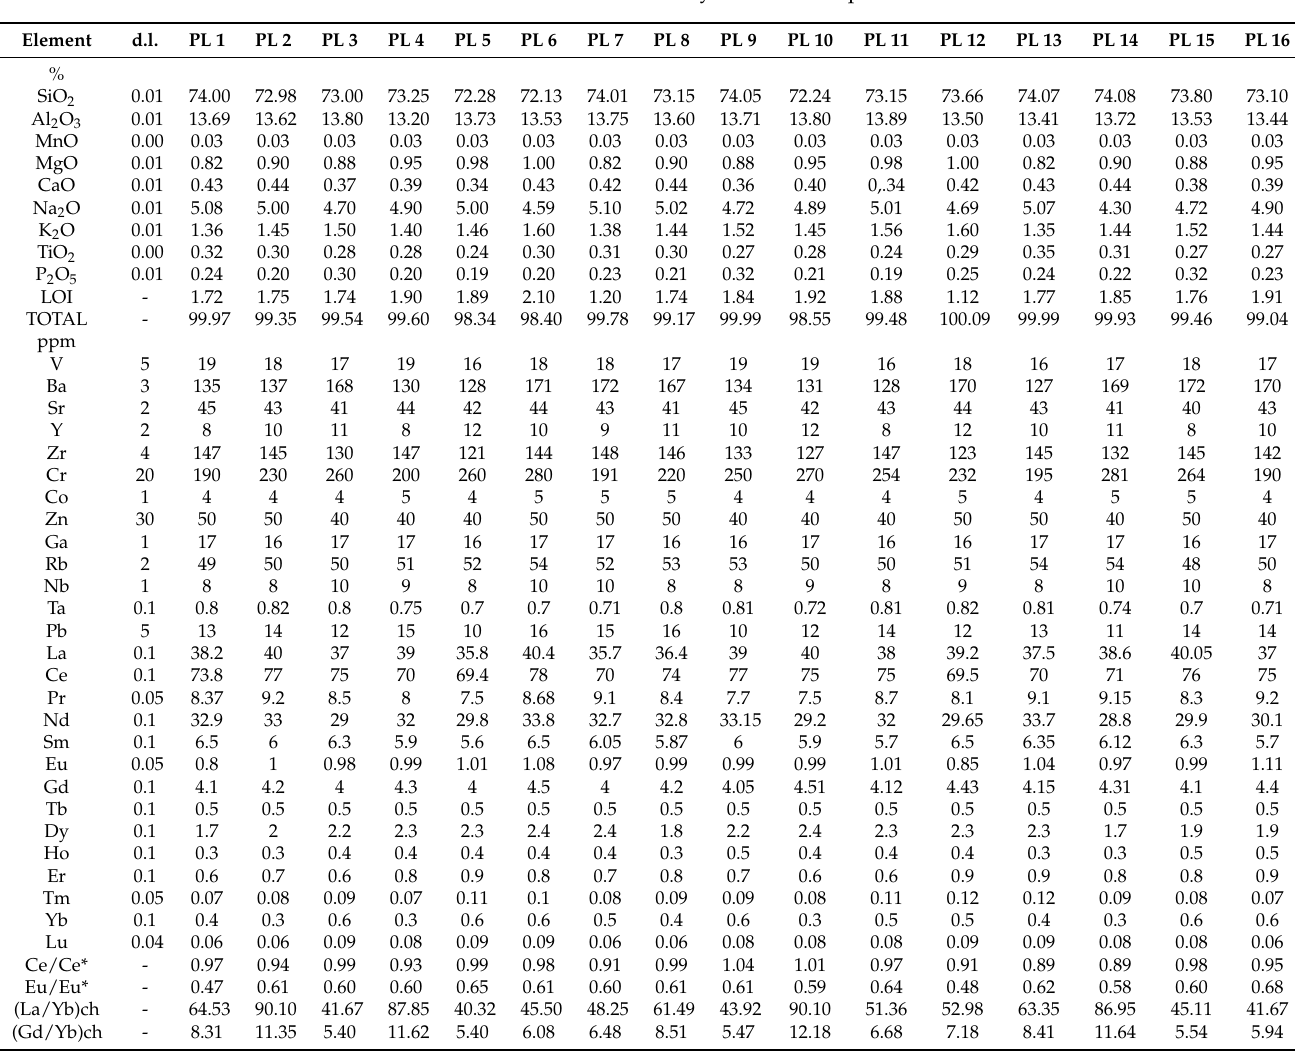
Table 1. Whole-rock chemistry of the 16